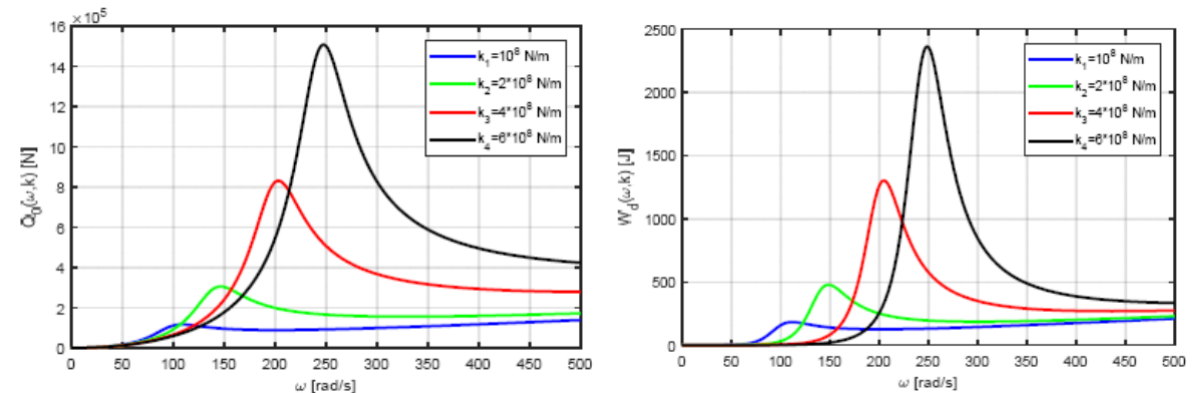
Figure 4. Variation of the dissipated energy in relation to (cid:2033) and (cid:1863) .